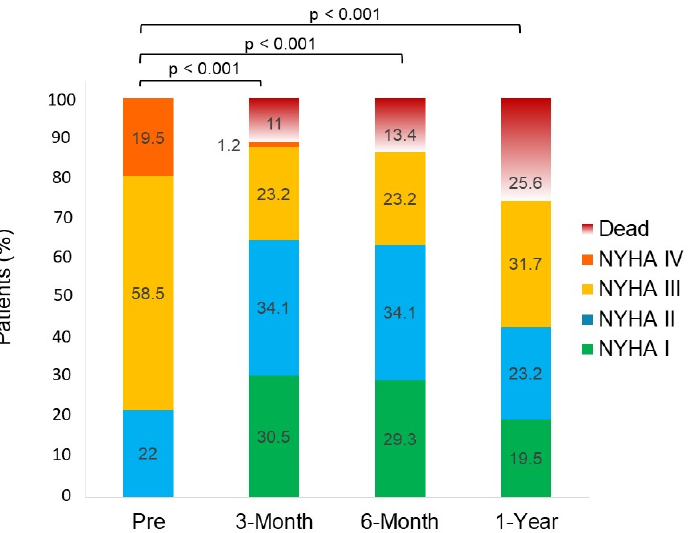
Figure 1. Changes in NYHA Functional class at baseline and at 3-Month, 6-Month and 1-Year after TEEMr.